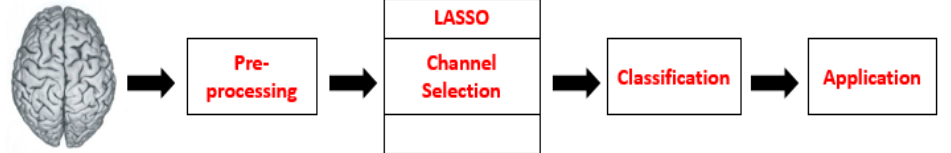
Figure 2. BCI system with LASSO-based sparse representation classification for channel selection .